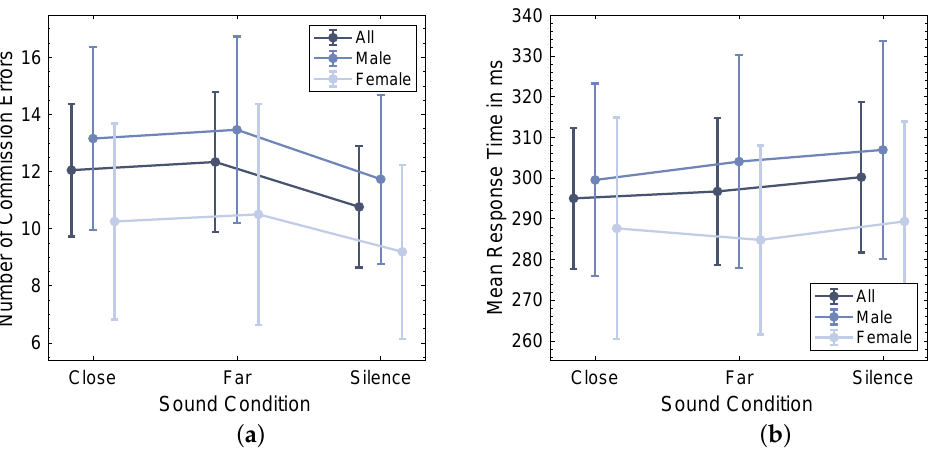
Figure 7. Means and 95% confidence intervals of number of commission errors ( a ) and mean response time ( b ) in continuous performance